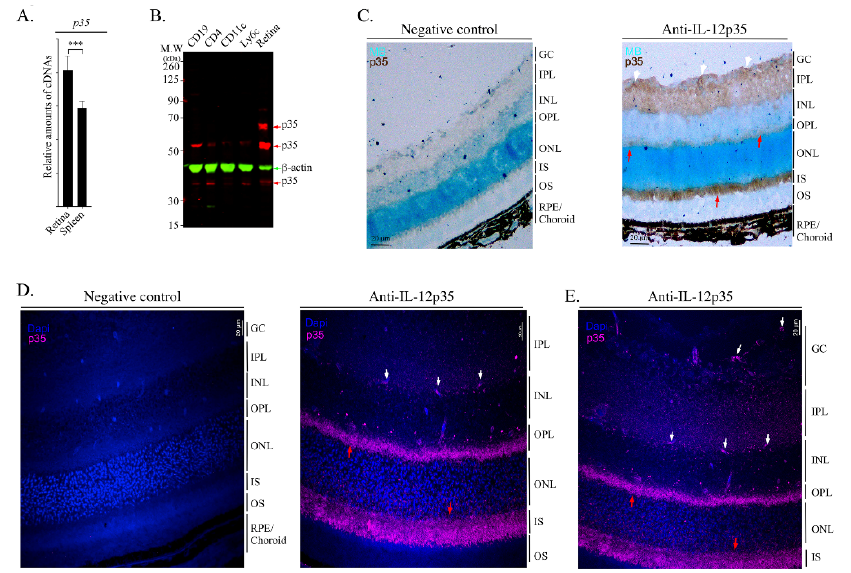
Figure 3. IL-35 is highly expressed in retinal rod and cone photoreceptors. ( A ) qPCR analysis of p35, ebi3 IL-10 mRNA transcripts in the retina and spleen of WT mice. ( B ) Western blot analysis of whole cell extracts prepared from sorted CD4 + T cells, CD19 + B cells, dendritic cells (CD11c) and monocytes